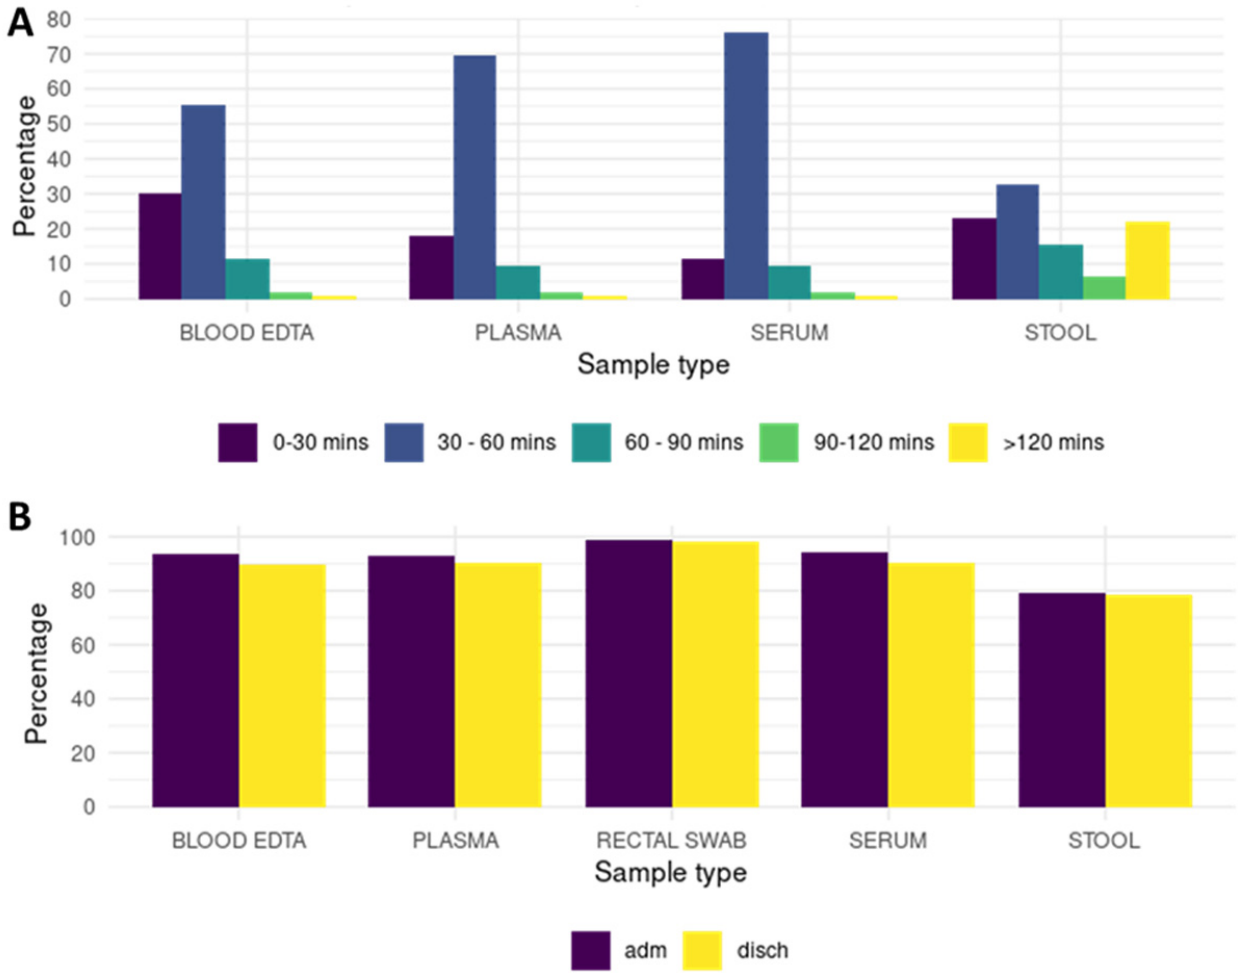
Figure 1. A. Duration of time from sample collection to storage at -80°C. ~80% of the samples (whole blood, plasma, serum, and rectal swabs) achieved a median of 44 minutes from collection to storage at a -80°C freezer. Except for stool, the rest of the samples were frozen at a -80°C freezer within 1 hour of collection. B. Proportion of samples available for analysis within the nested case cohort study. Greater than 90% of the selected study children have available samples for analysis. Approximately 80% of the study participants have stool samples available for analysis. Adm = admission, disch =